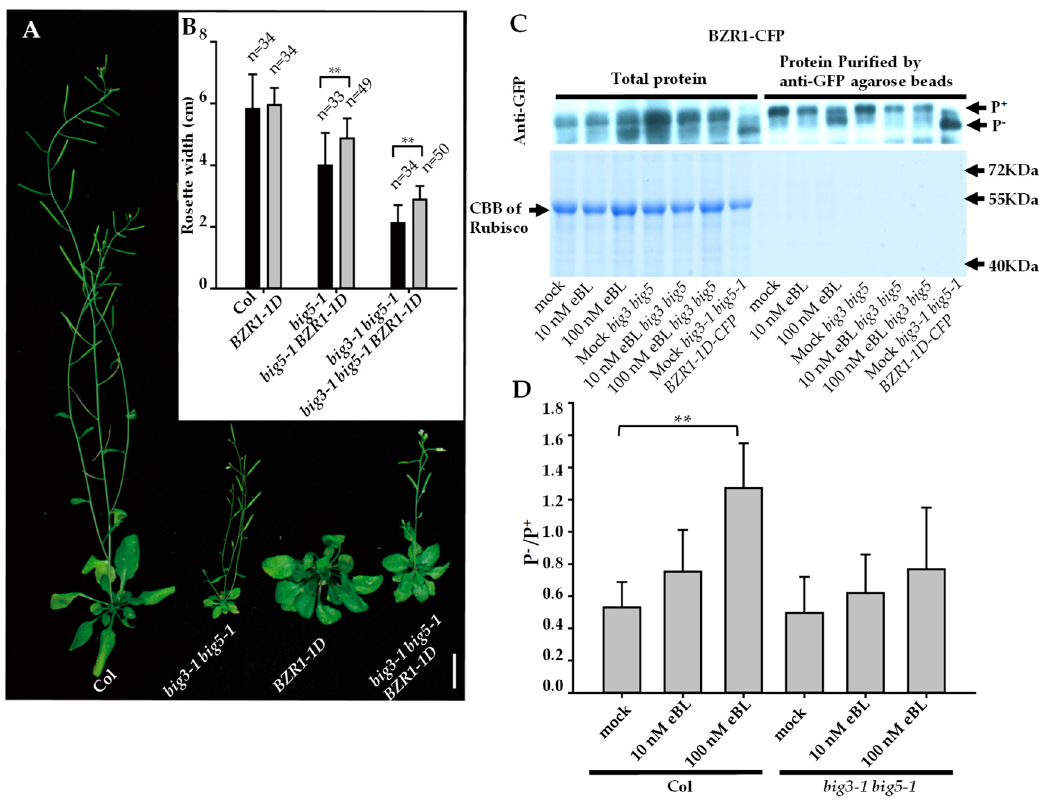
Figure 6. BIG5 and BIG3 act upstream of transcription factor BZR1 in BR signaling pathway. ( A – B ) Gain-of function BZR1-1D partially rescued the big3-1 big5-1 phenotype in plant size ( A ). Quantitative analysis of rosette width ( B ). ( C ) Western blot analysis of the BZR1-CFP dephosphorylation in 7 dag big3-1 big5-1 double mutant and WT (Col-0) in the presence or absence of eBL. In Col the BZR1 dephosphorylation level obviously increased as gradient eBL added, while the dephosphorylation BZR1 in big3-1 big5-1 failed to response to eBL. By contrast, gain-of-fucntion BZR1-1D-CFP conferred the dephosphorylation in big3-1 big5-1 mutants. The bottom box is CBB gel showing the Rubisco proteins as the loading control. ( D ) Quantitative analysis of the percentage of dephosphorylated BZR1 relative to the total BZR1 detected. Bar = 2 cm . Error bars represent standard deviations, significant difference after Student’s t -test, ** p < 0.01.